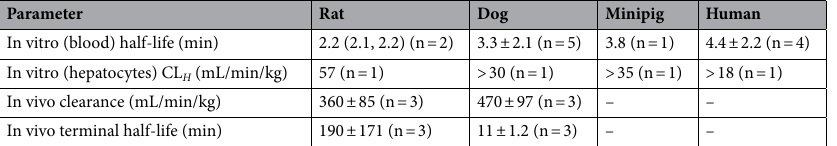
Table 2. Metabolic in vitro stability of LEO 134310 in mouse, rat, dog, minipig and human whole blood and hepatocytes and in vivo PK parameters in rat and dog. Predicted hepatic clearance (CL H ) from hepatocytes (well stirred model). Mean values ± S.D.